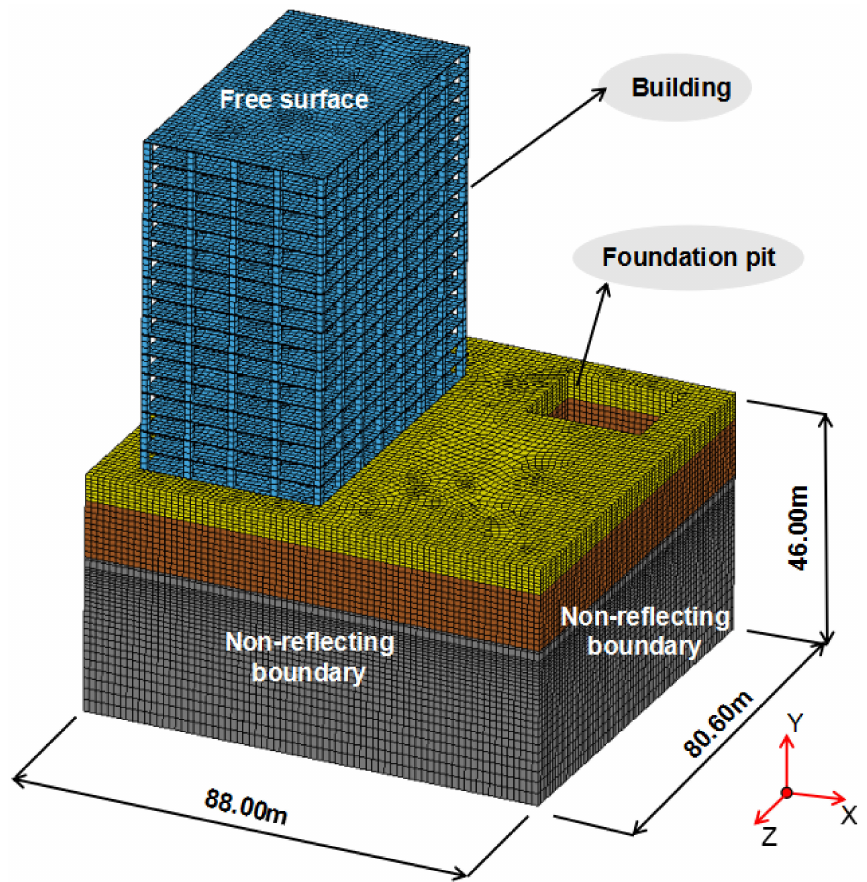
Figure 5. Zoning and boundary